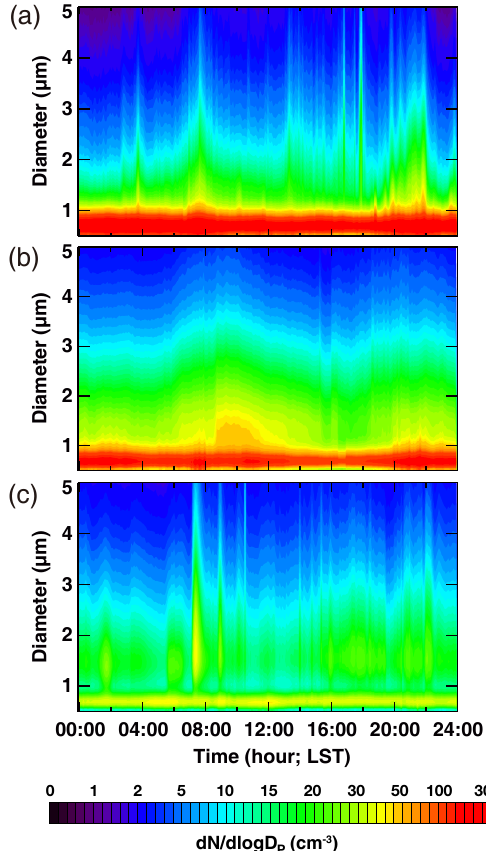
Figure 7. Histograms of 5 min averaged single-scattering albedo at 637nm in (a) Wuwei, (b) Zhangye, and (c) Dunhuang. The num- bers of samples and average values are also shown. Note that data collected during the strong dust storm in Zhangye are